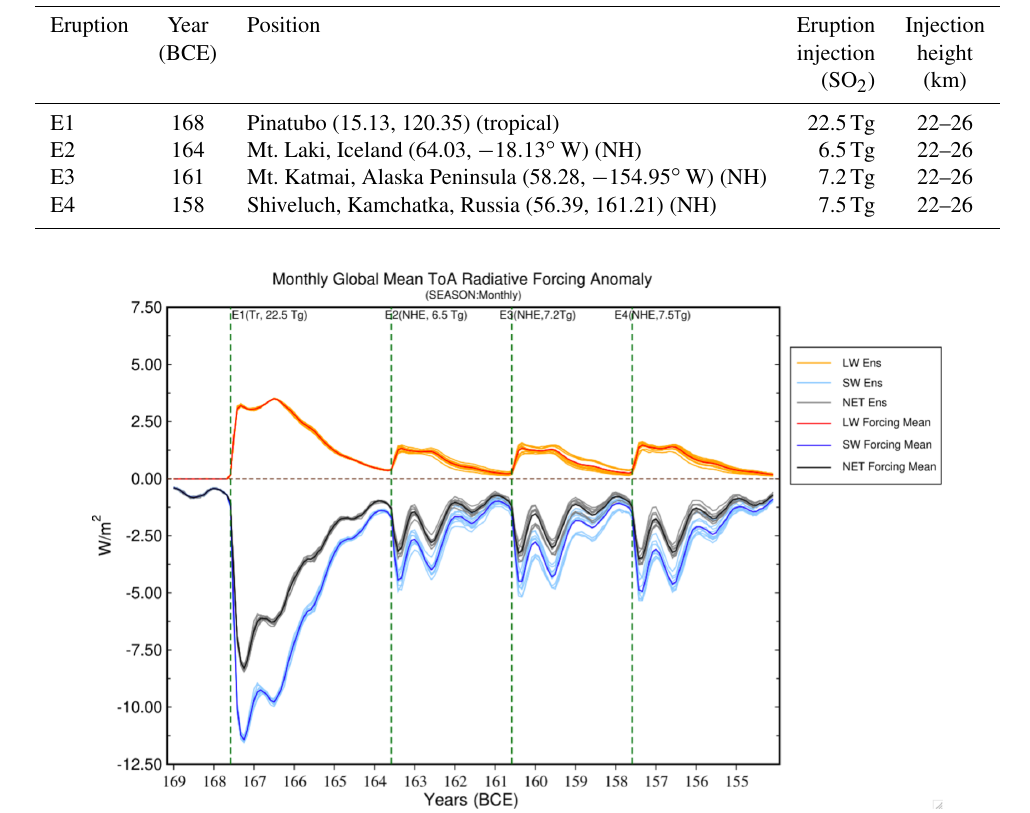
Table 1. Details of eruptions applied in this experiment, with each eruption happening on 15 June of the 2nd, 6th, 9th, and 12th model years.